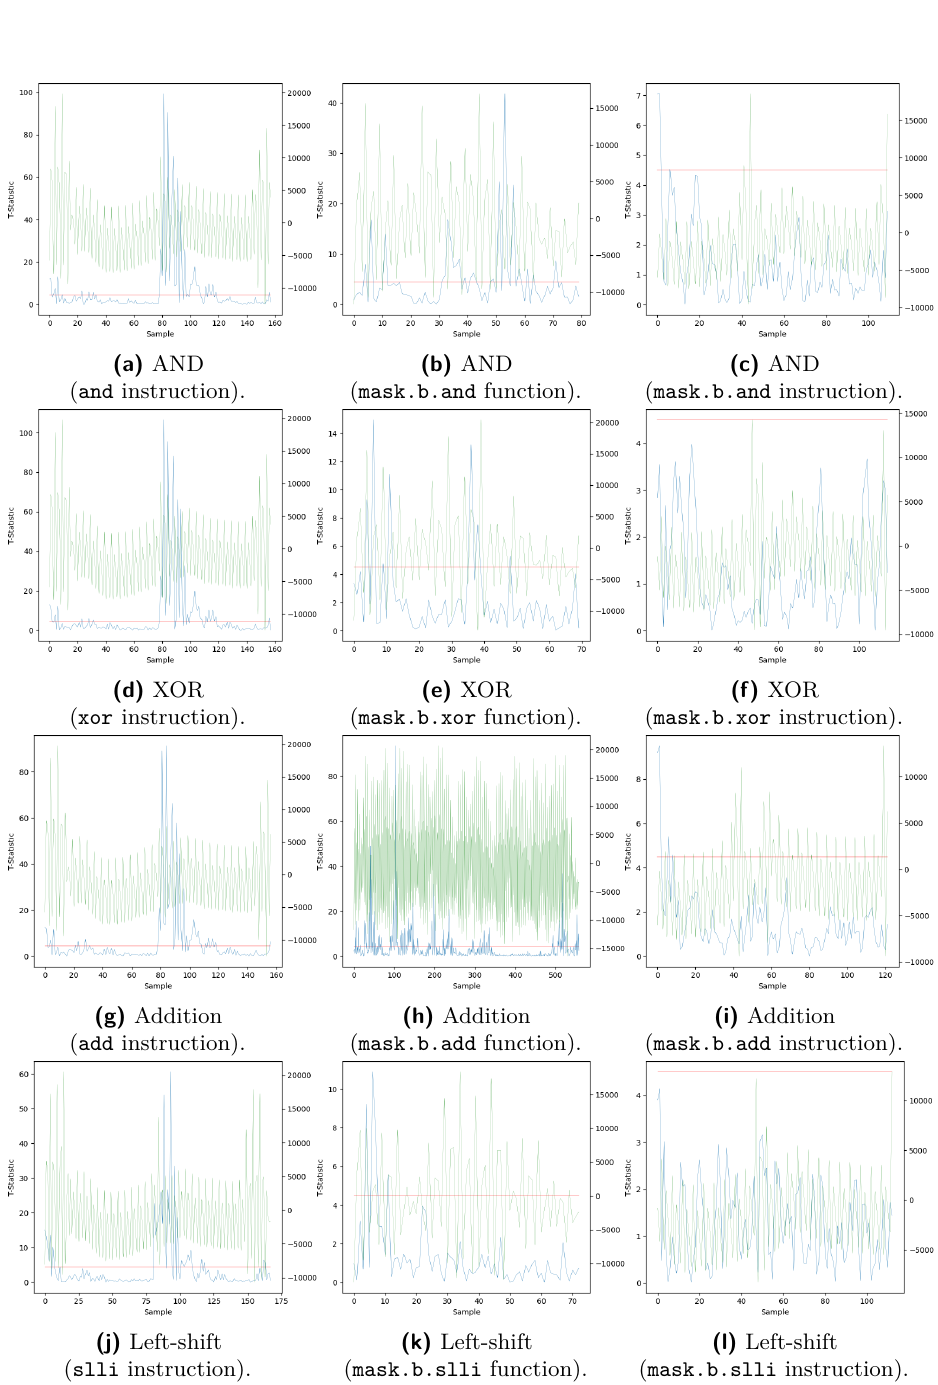
Figure 4: Comparison of leakage for selected instructions as executed on the SCARV core, for unmasked (left), ISA-masked (middle), and ISE-masked (right) cases. Each case relates to a set of 100 , 000 power consumption traces: the green plot shows the average of said traces, whereas the blue plot shows the (absolute) t-statistic stemming application of TVLA-based leakage detection to